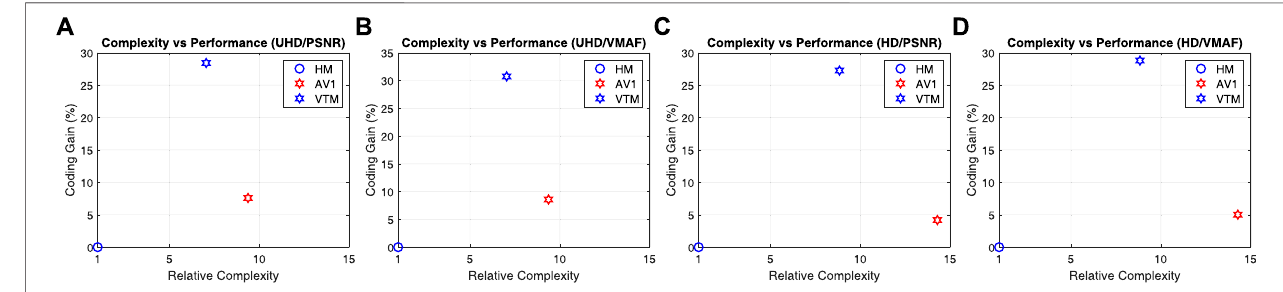
FIGURE 8 | The relationship between the relative codec complexity (benchmarked on HM) and encoding performance (in terms of average coding gains) for different resolution groups and quality metrics: (A) UHD/PSNR, (B) UHD/VMAF, (C) HD/PSNR, and (D) HD/VMAF.